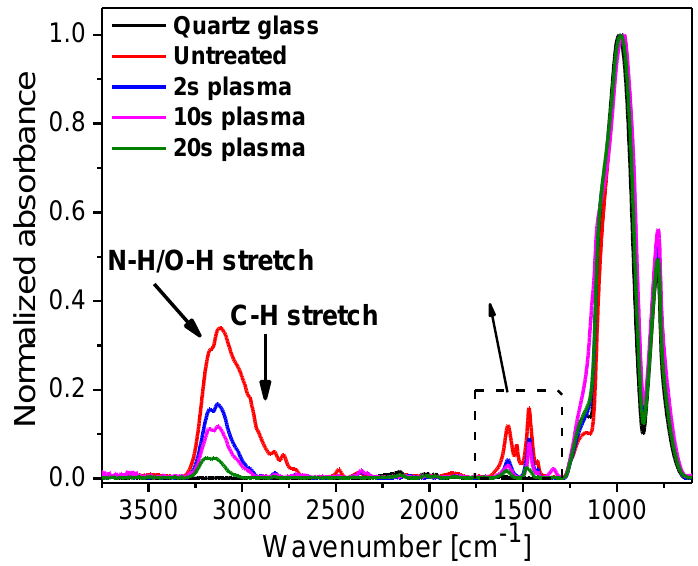
Figure 5. ATR-FTIR pattern of mixed-halide perovskite film before and after plasma treatment.